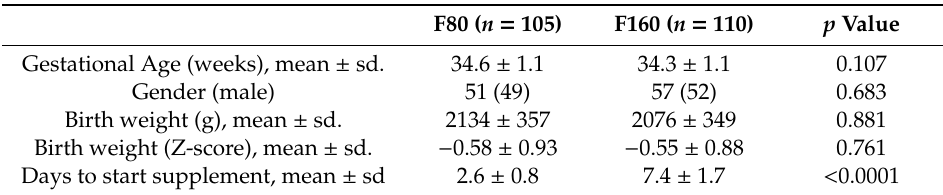
Table 1. Infant baseline